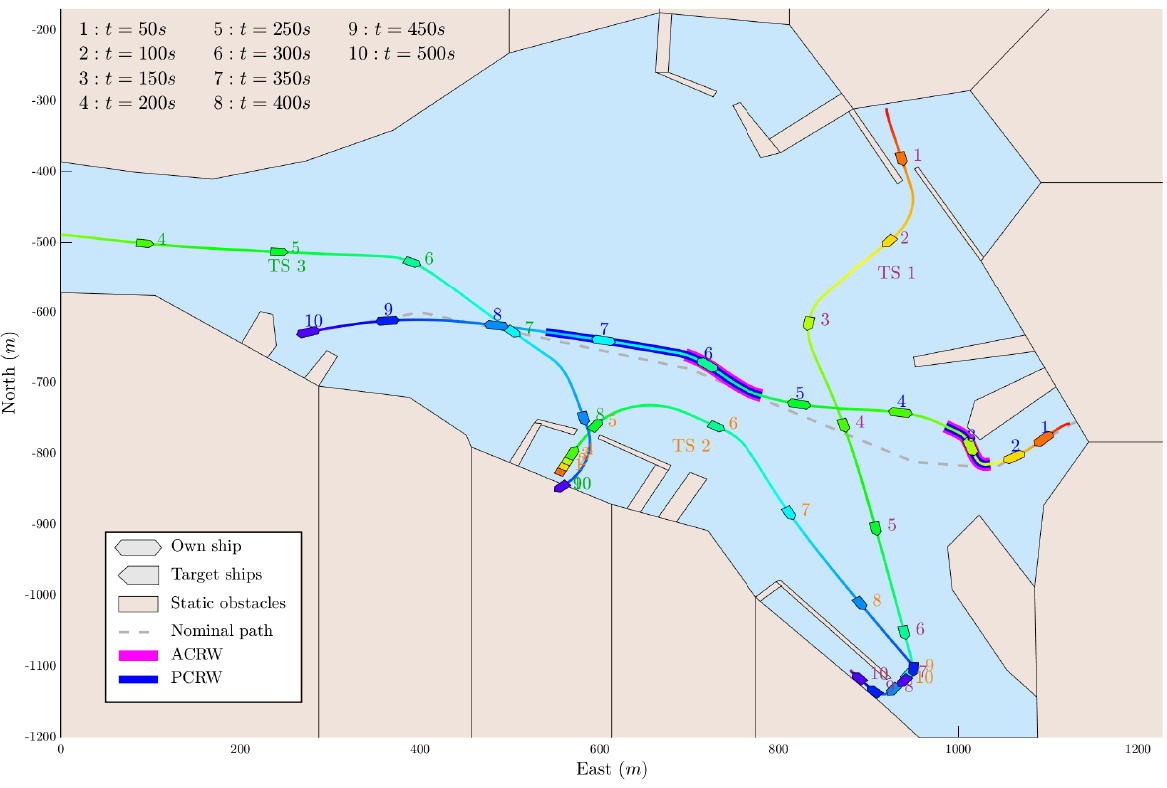
Figure 18: Simulation 3: Transit between two docking locations, with a give-way crossing, stand-on crossing and a head-on/give-way